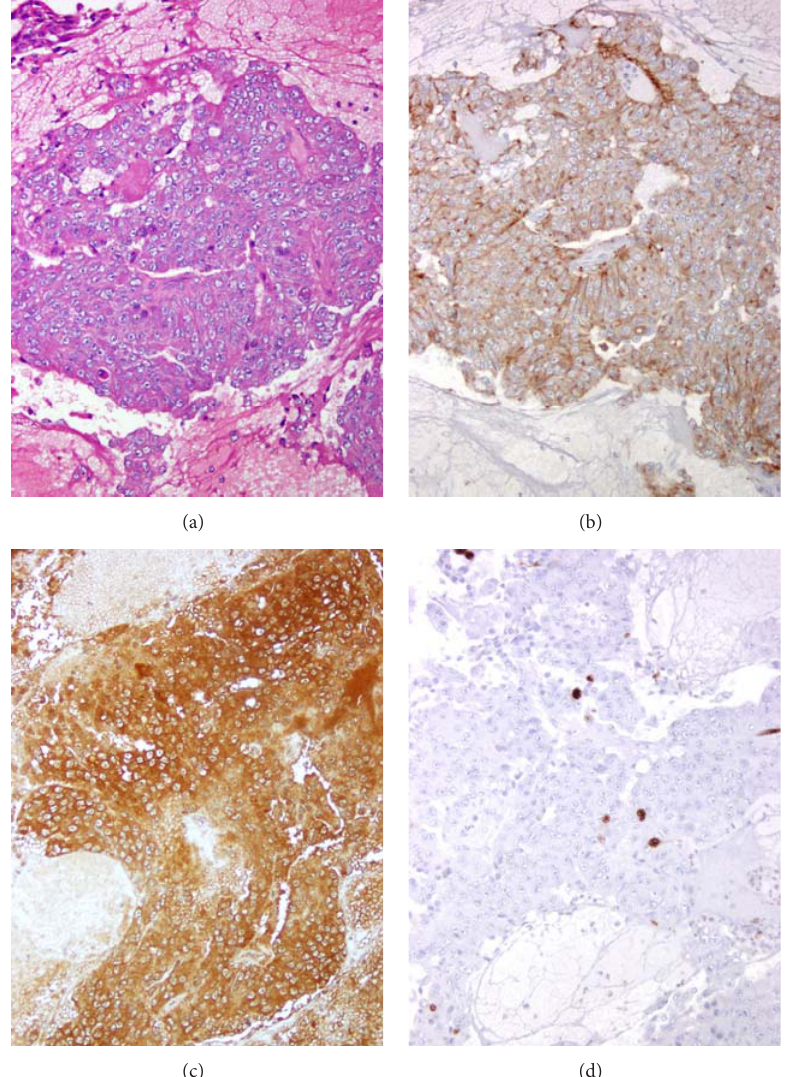
Figure 4: Pathologic evaluation, all at 20x magnification. (a) Histologic sections demonstrate an epithelial neoplasm composed of monomorphic cells with increased nuclear to cytoplasmic ratios and prominent nucleoli. (b) Immunohistochemical staining positive for